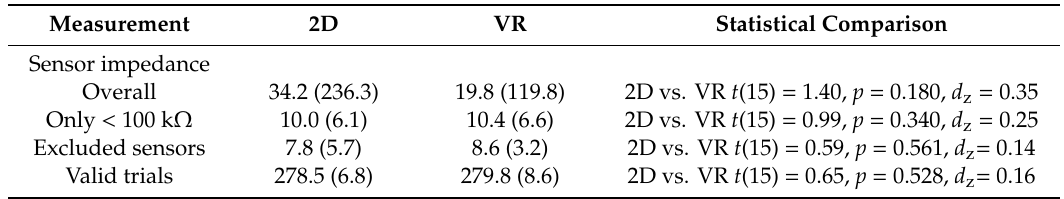
Table 1. EEG data